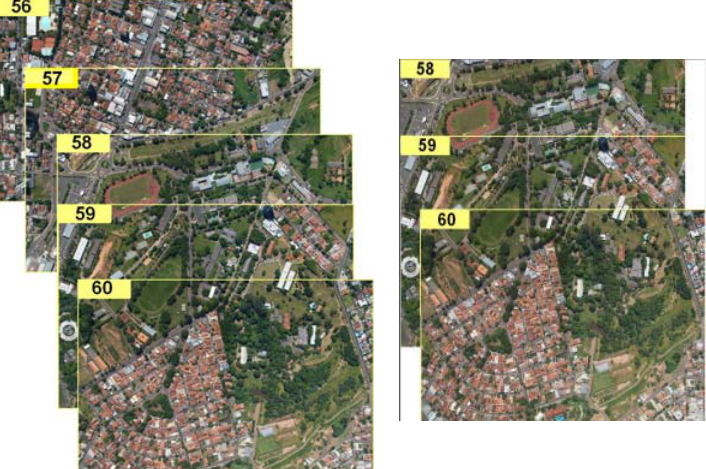
Figure 8. ( a ) Set of virtual images used in the fusion experiments; ( b ) reduced set used in the bundle block